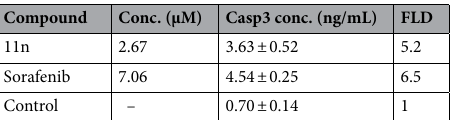
Table 3. The concentration of caspase-3 in MCF-7 cells after treatment with compound 11n for 24